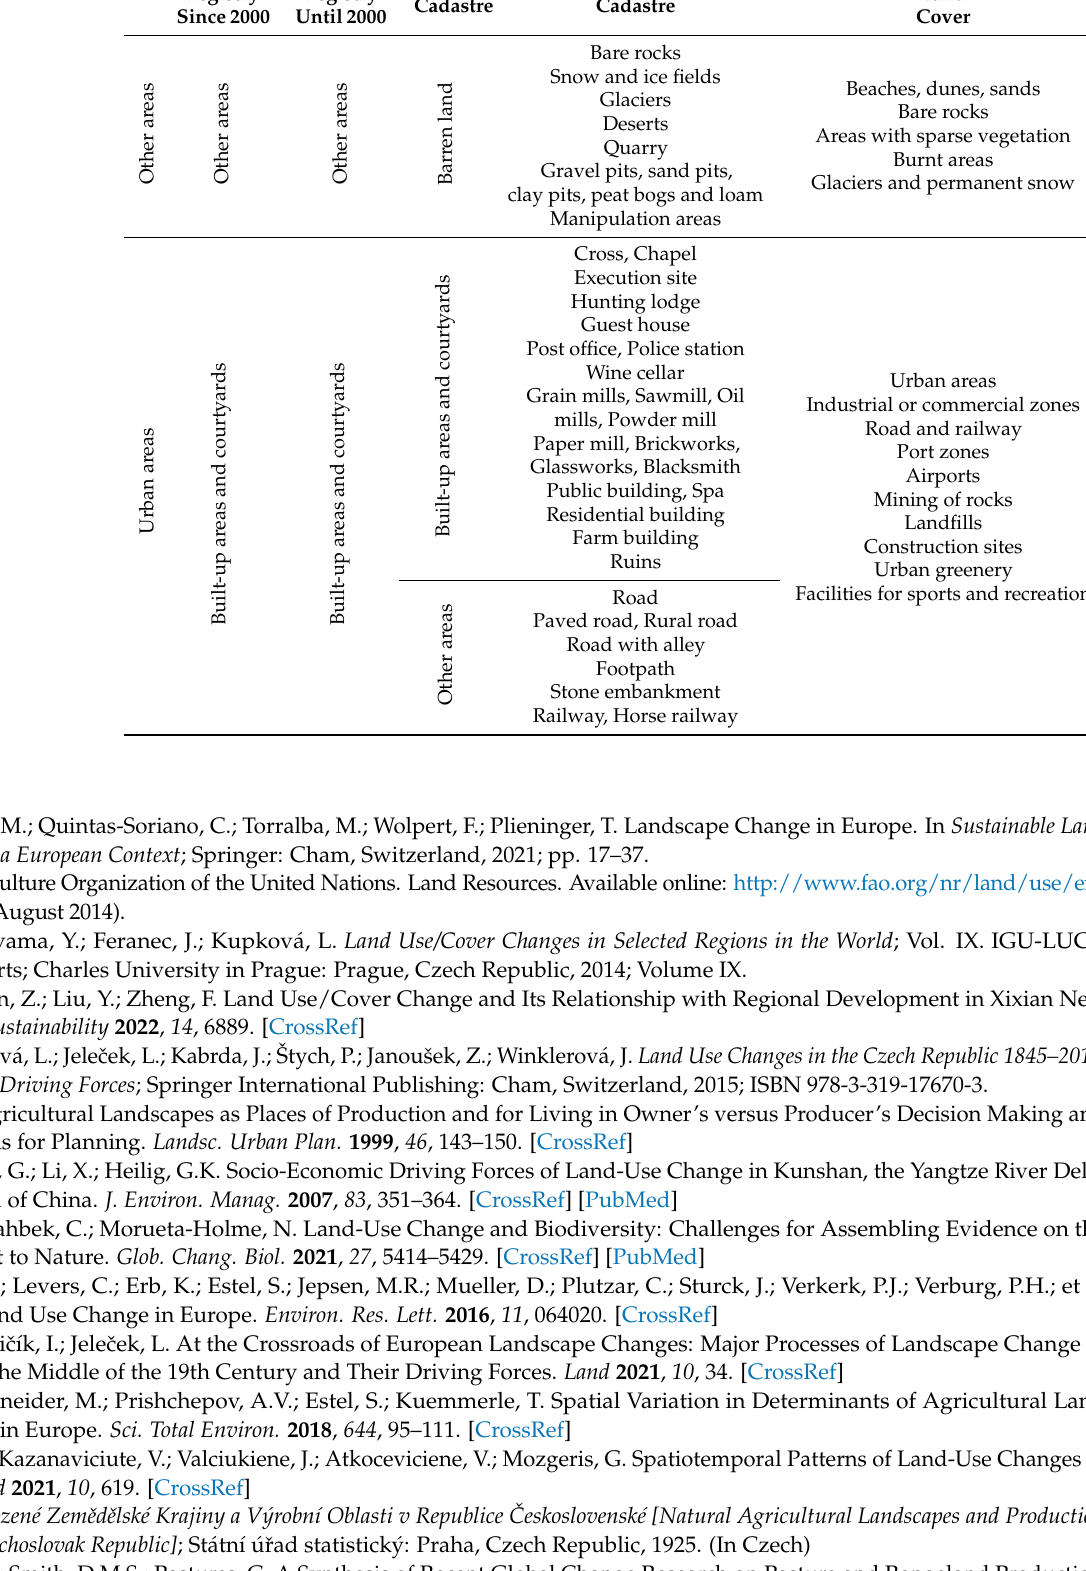
Stable Cadastre